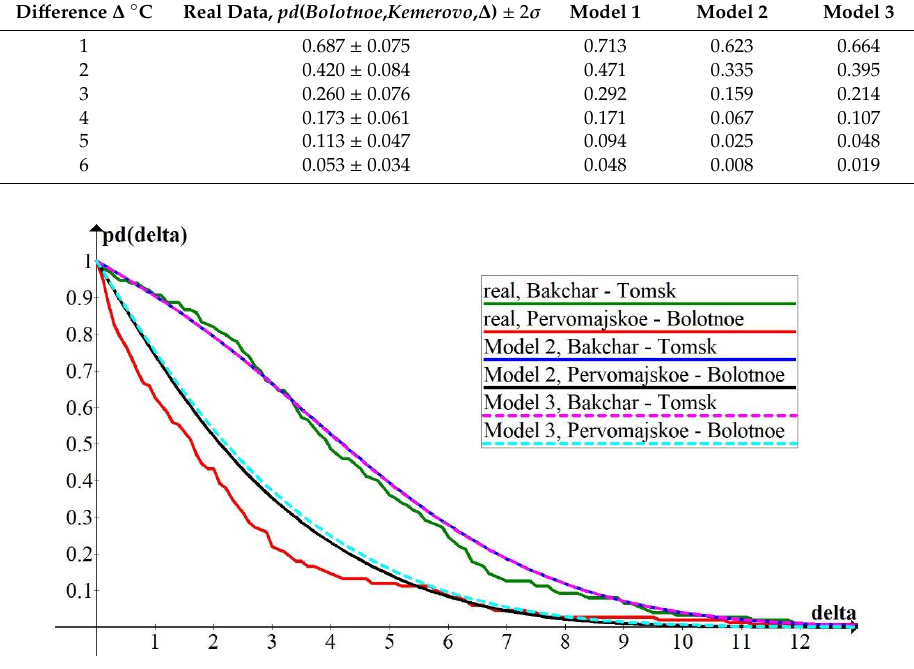
Figure 6. Probability pd ( station 1 , station 2 , ∆ ) , Area 1, 15